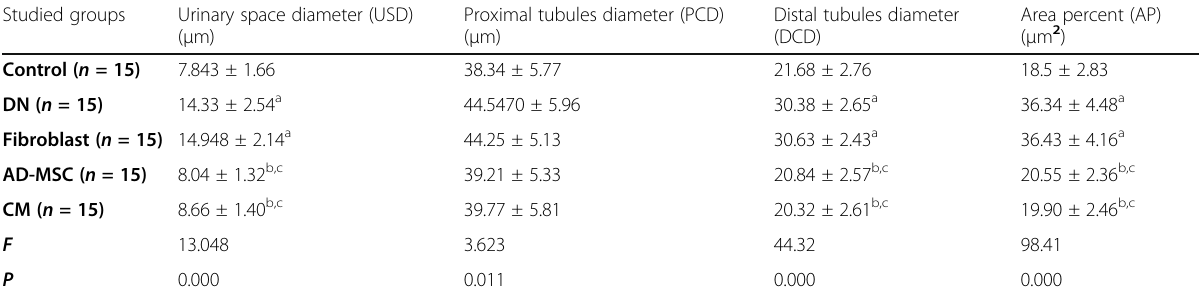
Table 5 Morphometric analysis of urinary space proximal tubules and distal tubules diameters and area percent of connective tissue surrounding the tubules and within the glomeruli in the different studied groups Studied